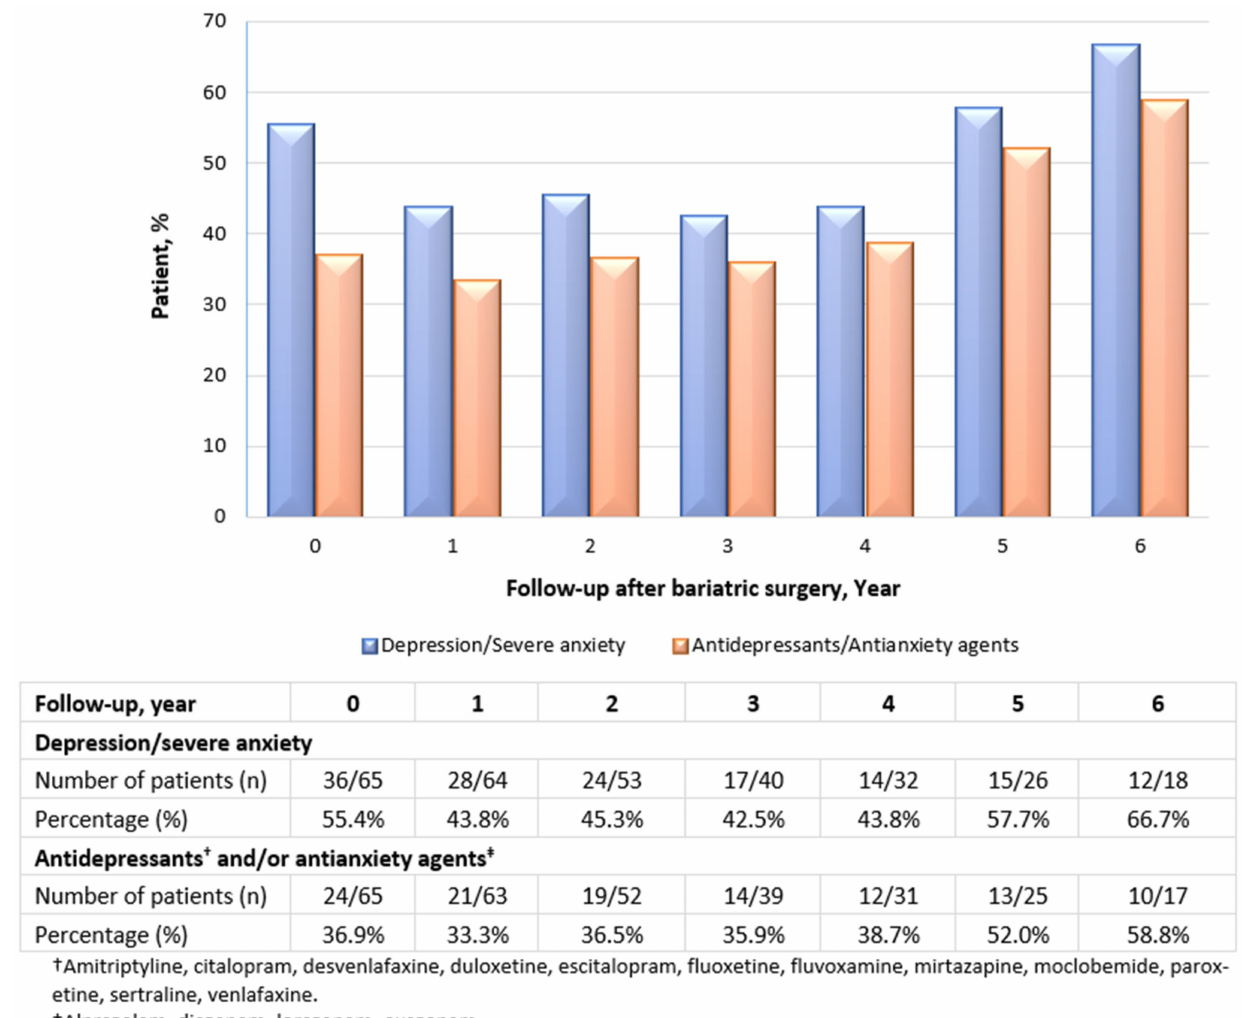
Figure 6. Prevalence of depression/severe anxiety, as well as the use of antidepressants and/or antianxiety agents among the study